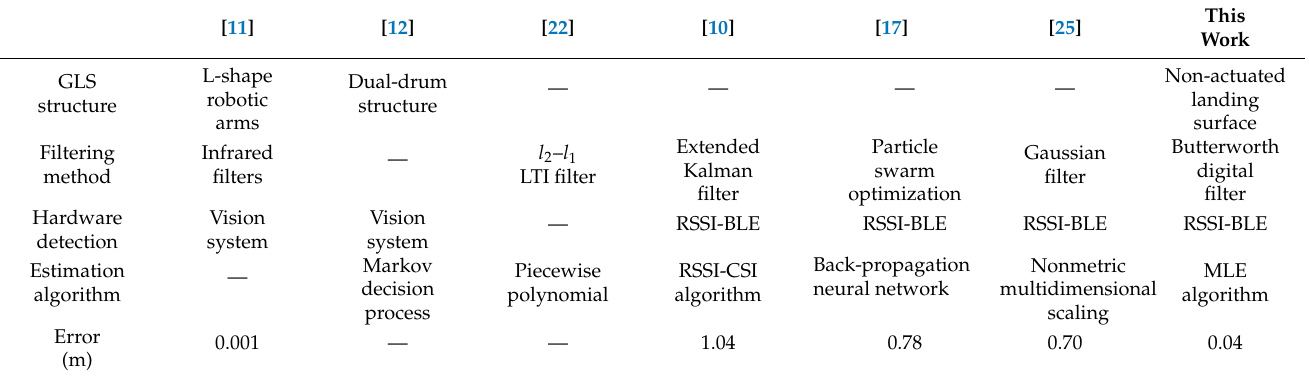
Table 2. Comparative analysis of ground landing stations and target position estimation for